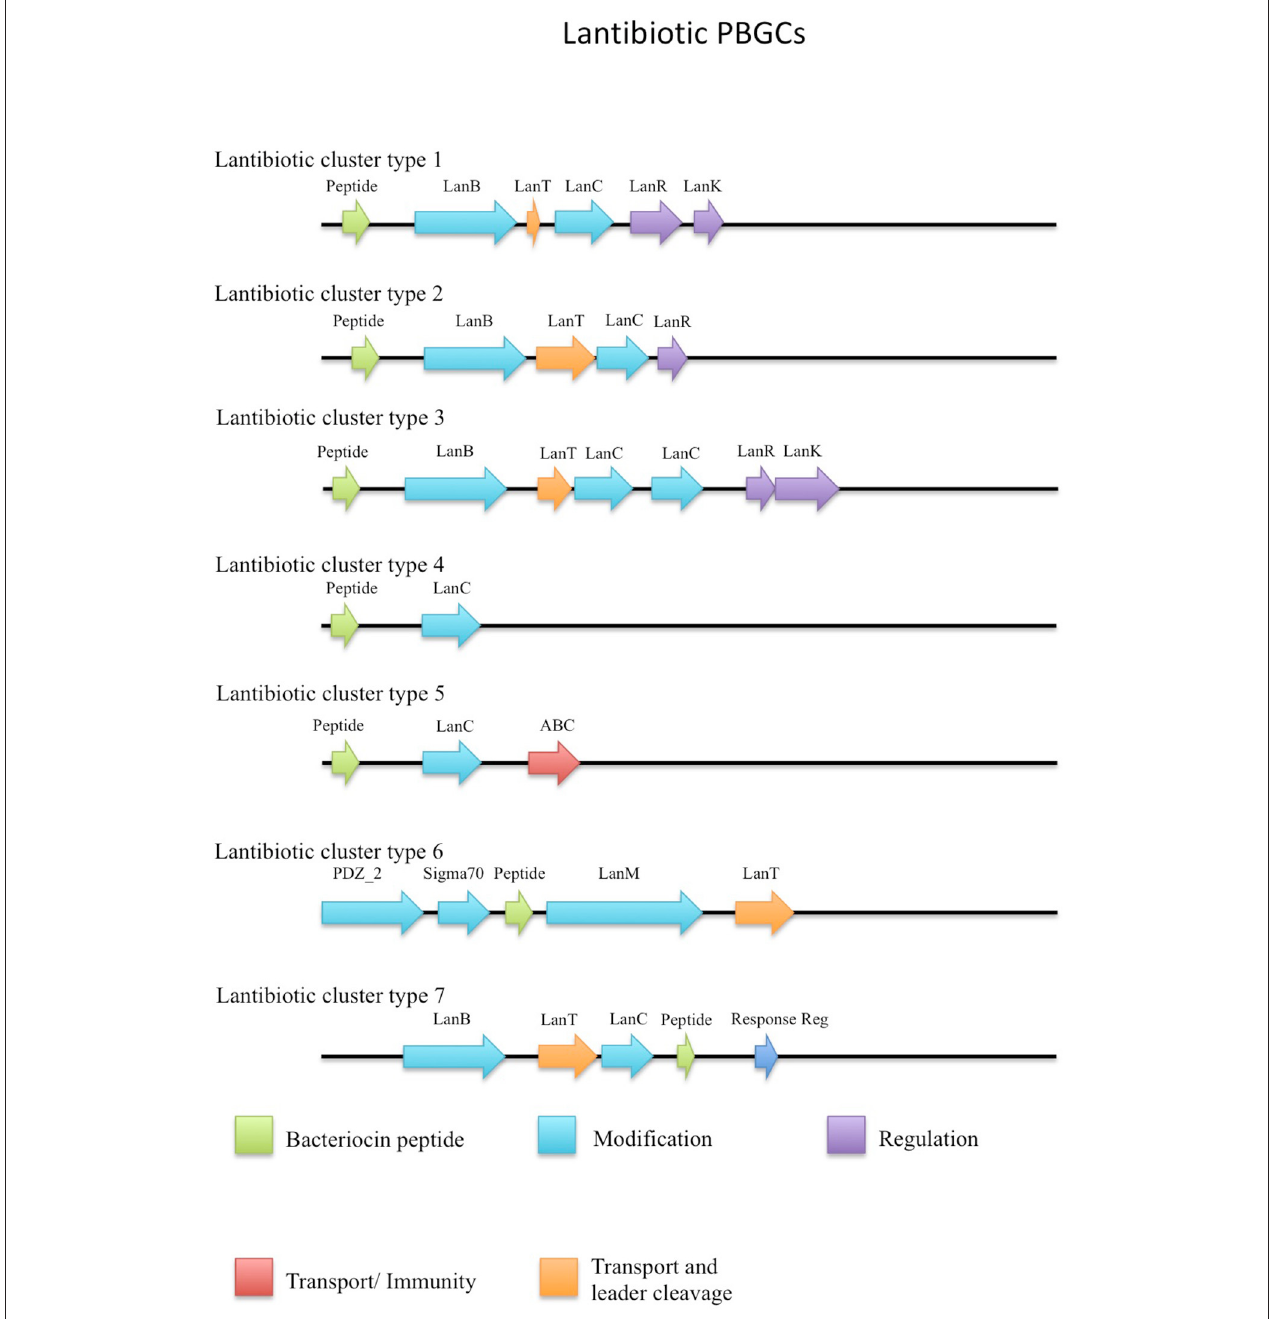
FIGURE 3 | Lantibiotic cluster types predicted by